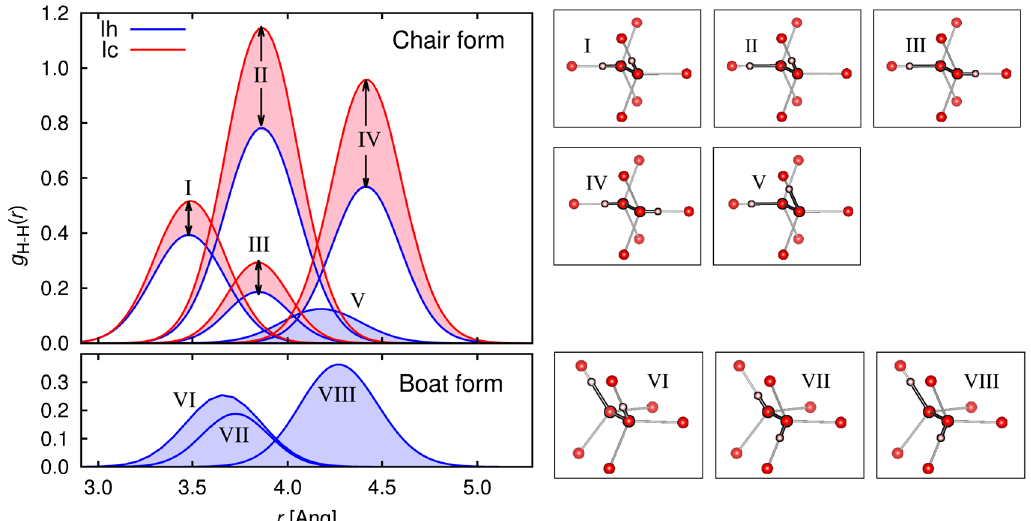
FIG. 11. Anharmonic H-H RDF decomposed into contributions from different bonding configurations of fourth-nearest-neighbor pairs of protons. The upper part shows the components corresponding to the chair-form hexamer configurations I – V found in both Ih and Ic. The lower part shows the components corresponding to the boat-form hexamer configurations VI – VIII, which are exclusive to Ih. In configurations VI – VIII the hydrogen bridge bonds associated with the pairs of protons (shown as small white spheres) are at a larger angle to each other than in I –